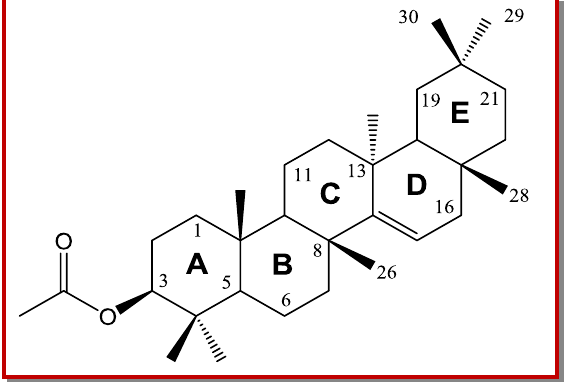
Figure 1: Chemical structure of taraxerol